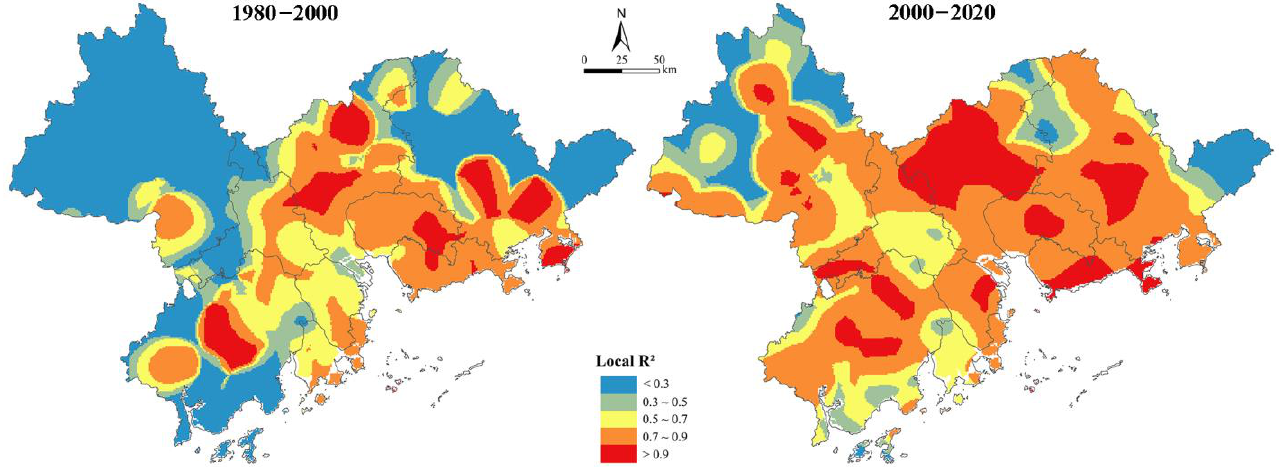
Figure 5. Local R 2 results for the GWR model